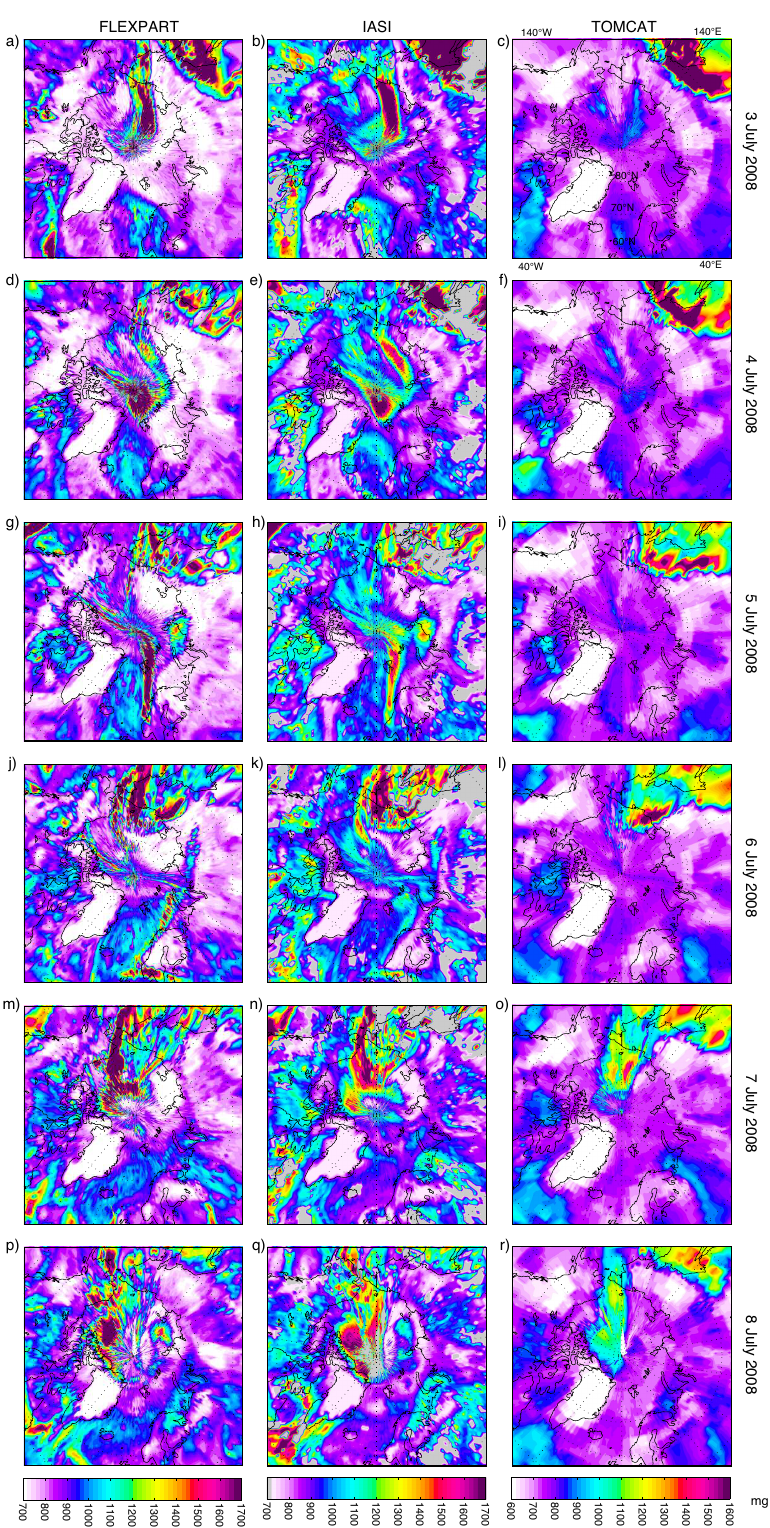
Fig. 7. Comparison of total column CO from FLEXPART (left column), IASI (center column) and TOMCAT (right column) in mgm − 2 during 3 to 8 July 2008. Displayed are IASI daylight composites. Model data are interpolated to the same time and location as the satellite retrievals and weighted with a mean IASI averaging kernel. Cloudy pixels in the IASI data are shown in white as missing data.